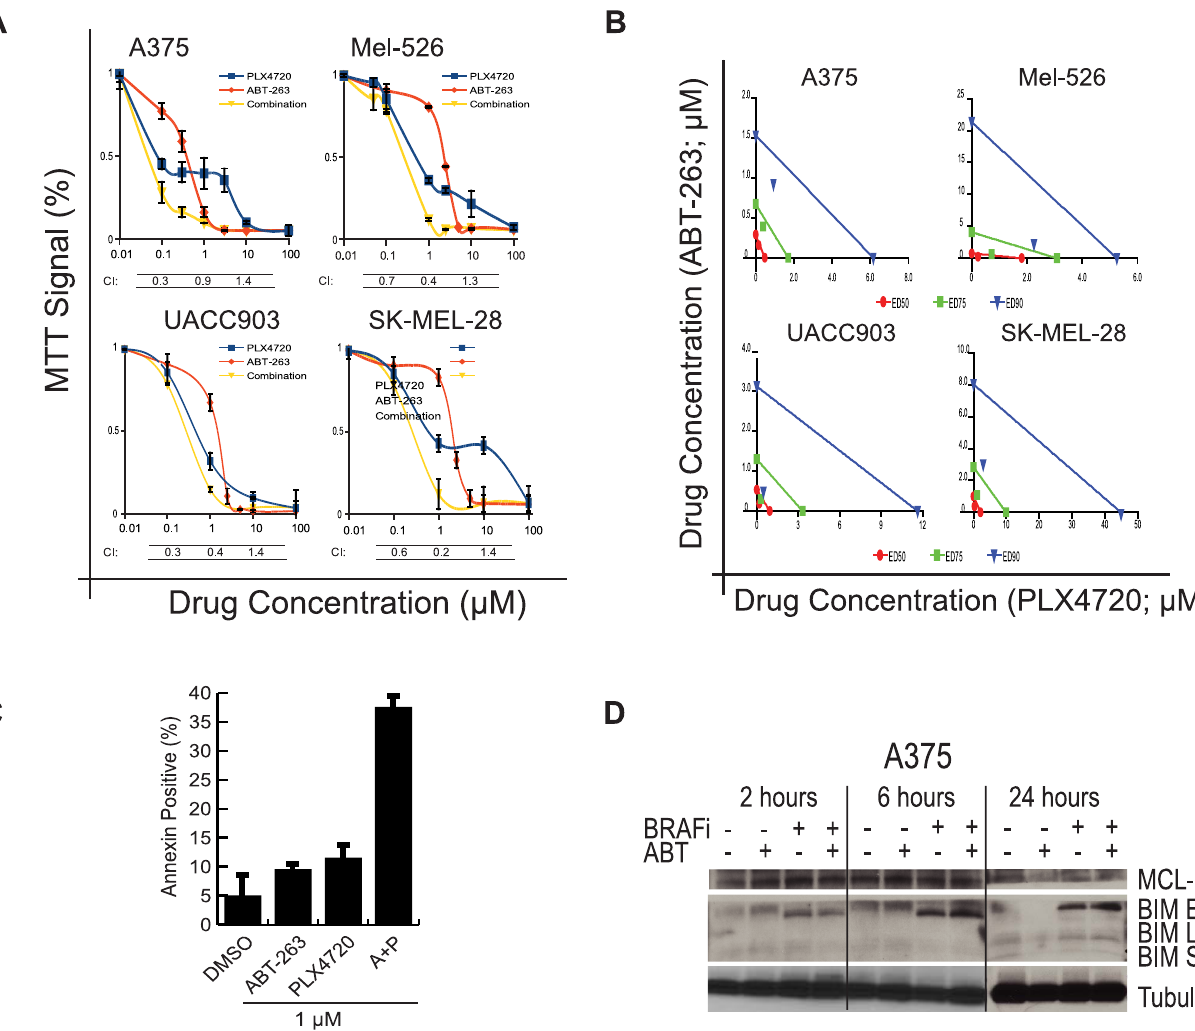
Figure 5. The effect of BRAF inhibition, BH3-mimetics or their combination on cell proliferation, apoptosis and protein expression levels of BCL2 family members in BRAF V600E melanoma cell lines. ( A ) MTT assay demonstrating the effect of BCL-2 inhibition, BRAF inhibition, and their combination, on cell proliferation with their respective combination index (CI) value. ( B ) Corresponding isobolograms. ( C ) Fluorescence activated cell-sorting (FACS) for Annexin after indicated drug treatment in a BRAF V600 cell line, A375. Drug combinations used at a 1:1 ratio. ( D ) Western blotting of BIM and MCL1 in a BRAF V600 cell line, A375 after 2, 6 and 24 hours treatment with a BRAFi, ABT and the combination of both BRAFi and